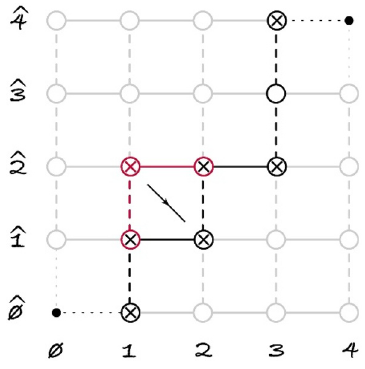
Figure 3 . The Bethe equations are defined on a path connecting the two trivial Q-functions Q = 1 = Q . The horizontal direction roughly corresponds to S 5 and the vertical direction 4 | b 4 ∅| b ∅ to AdS 5 in the dual string picture. The nodes at which the Dynkin diagram makes a turn are fermionic, and those which it passes straight are bosonic. The duality acts by flipping the path across a